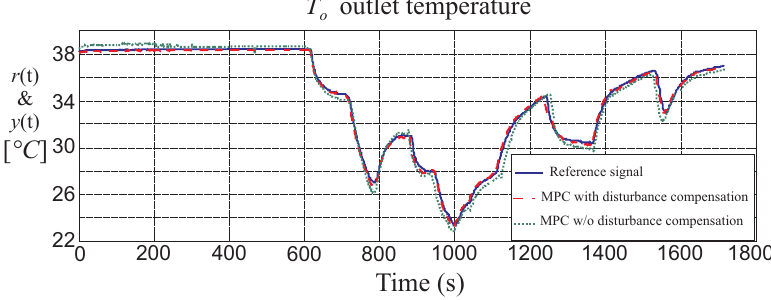
Figure 13. TU module outlet air temperature compensated by the linear MPC with and without disturbance d ( t )